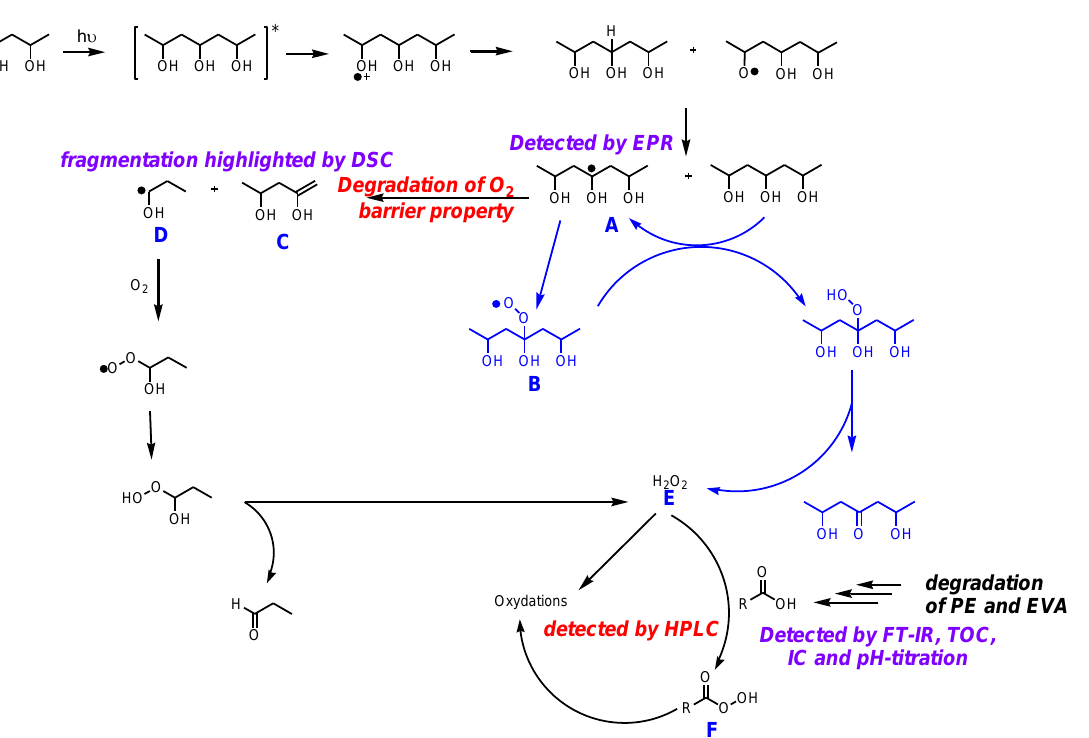
Scheme 7. Generation of hydrogen peroxide upon γ-irradiation of polyvinyl alcohol polymer block of EVOH .